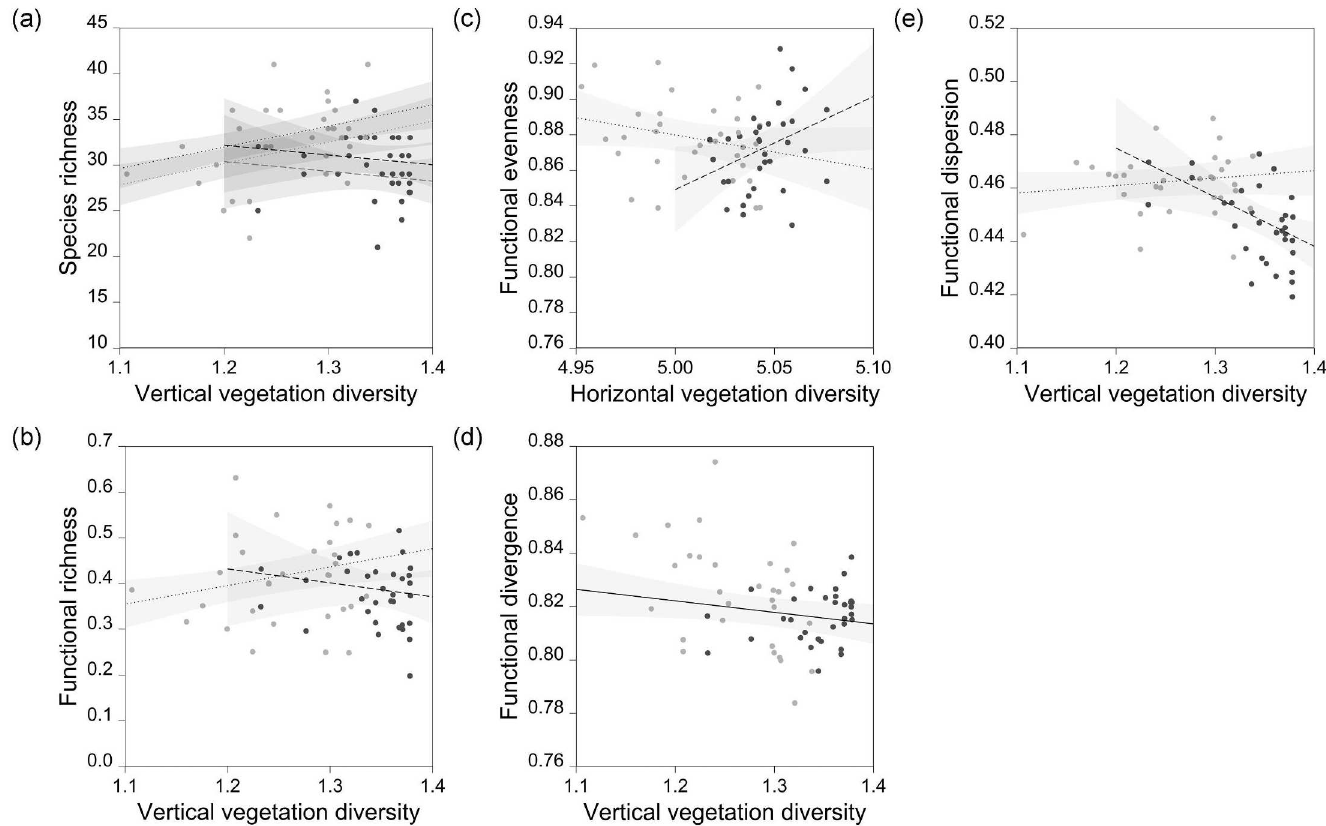
Fig 2. Responses of species richness and functional diversity to vegetation diversity indices. Predictionsand 95% confidence intervals are derivedfrom top-rankedlinear mixed models. Point colours and line types correspondto different forest types (dry forest = grey points, dotted lines; wet forest = black points, dashed lines). Lines corresponding to year 1 (grey) and year 2 (black) are displayed where year had a significant influenceon the response